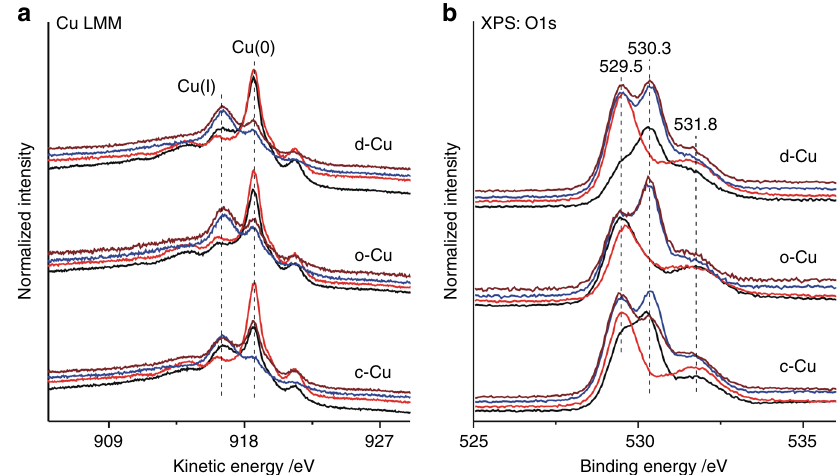
Fig. 4 Water activation. a Cu LMM AES and b O 1 s XPS spectra of various Cu NCs ( black lines ), Cu NCs exposed to H 2 O at 423 K ( red lines ), Cu NCs exposed to H 2 O at 523 K ( blue lines ) and Cu NCs exposed to H 2 O at 523 K and then to CO at 473 K ( brown lines ). All spectra were measured without exposure to